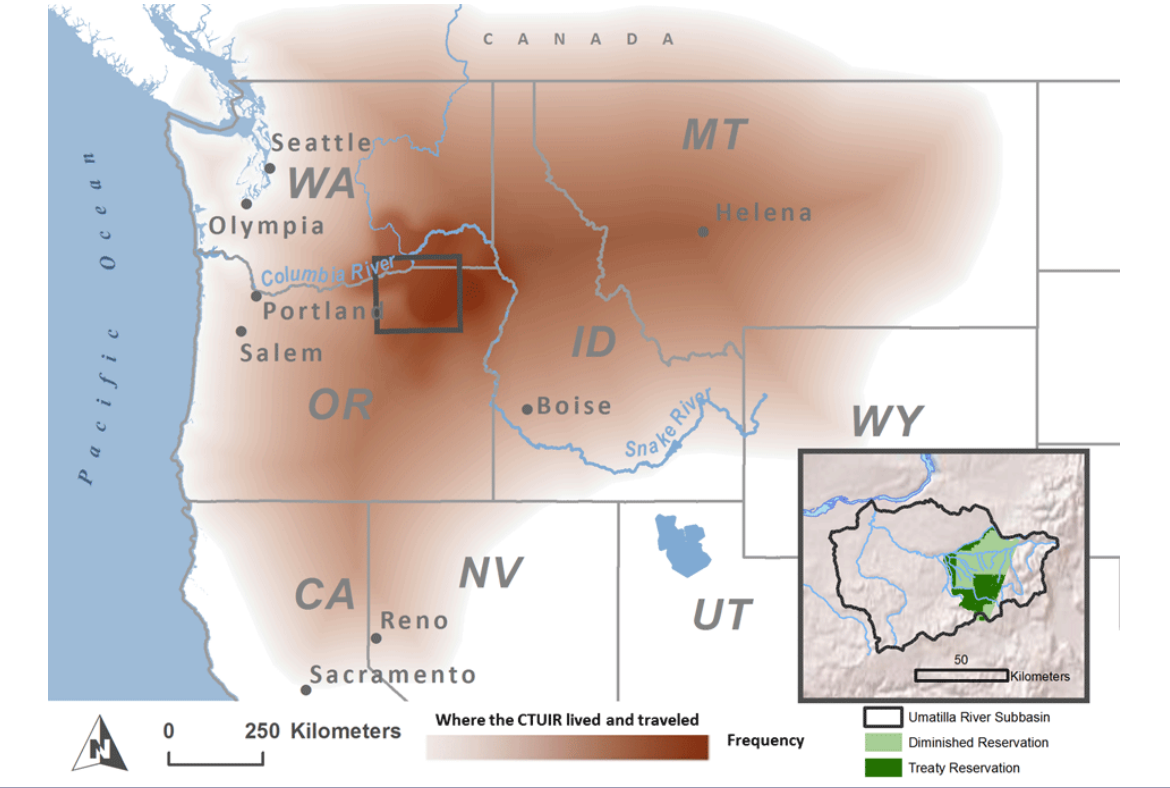
Fig. 1 . The diminished Umatilla Indian Reservation and where the three bands of the Confederated Tribes of the Umatilla Indian Reservation (the Cayuse, Umatilla, and Walla Walla people) historically traveled to hunt, fish, gather, socialize, and trade. Data and information used to create this map include the 1855 Treaty negotiation minutes, adjudicated use areas, oral histories information, and documentation from